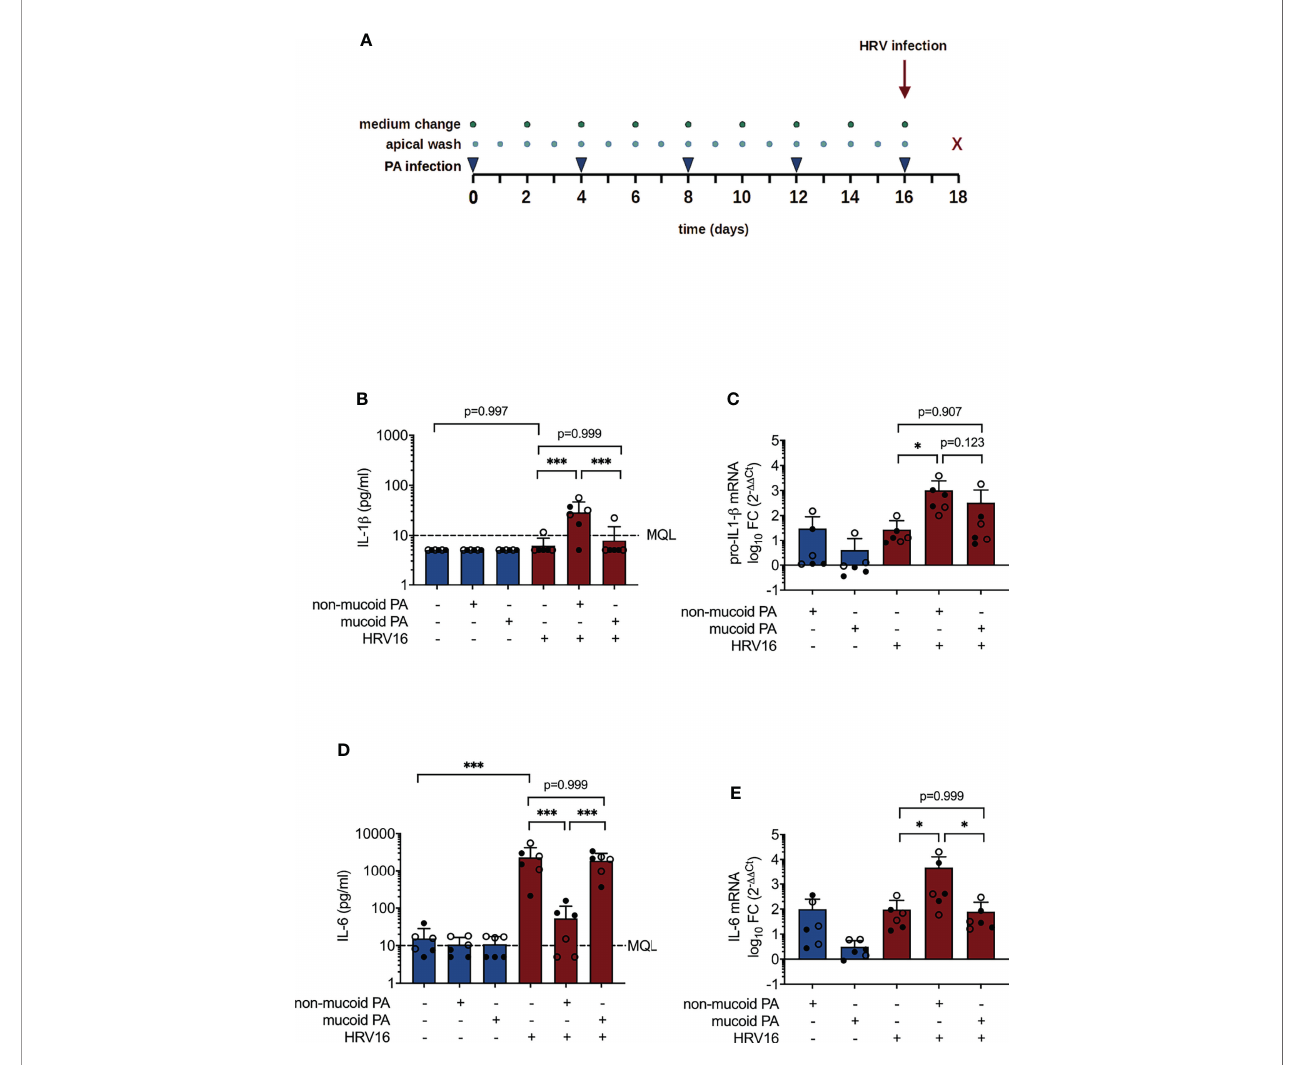
FIGURE 1 | Cytokine production in differentiated bronchial epithelial cells co-infected with P. aeruginosa (PA) and human rhinovirus 16 (HRV16). (A) Infection protocol/timeline (B) IL-1ß protein concentrations in basal media (C) pro-IL-1ß mRNA levels (D) IL-6 protein concentrations in basal media (E) IL-6 mRNA levels. MQL, Minimum quanti fi able level, FC, fold change. Cell type: ○ Emphysema ● Cystic fi brosis. Data were obtained in six independent experiments, each performed with cells derived from a different donor. *p ≤ 0.05, **p ≤ 0.01, ***p ≤